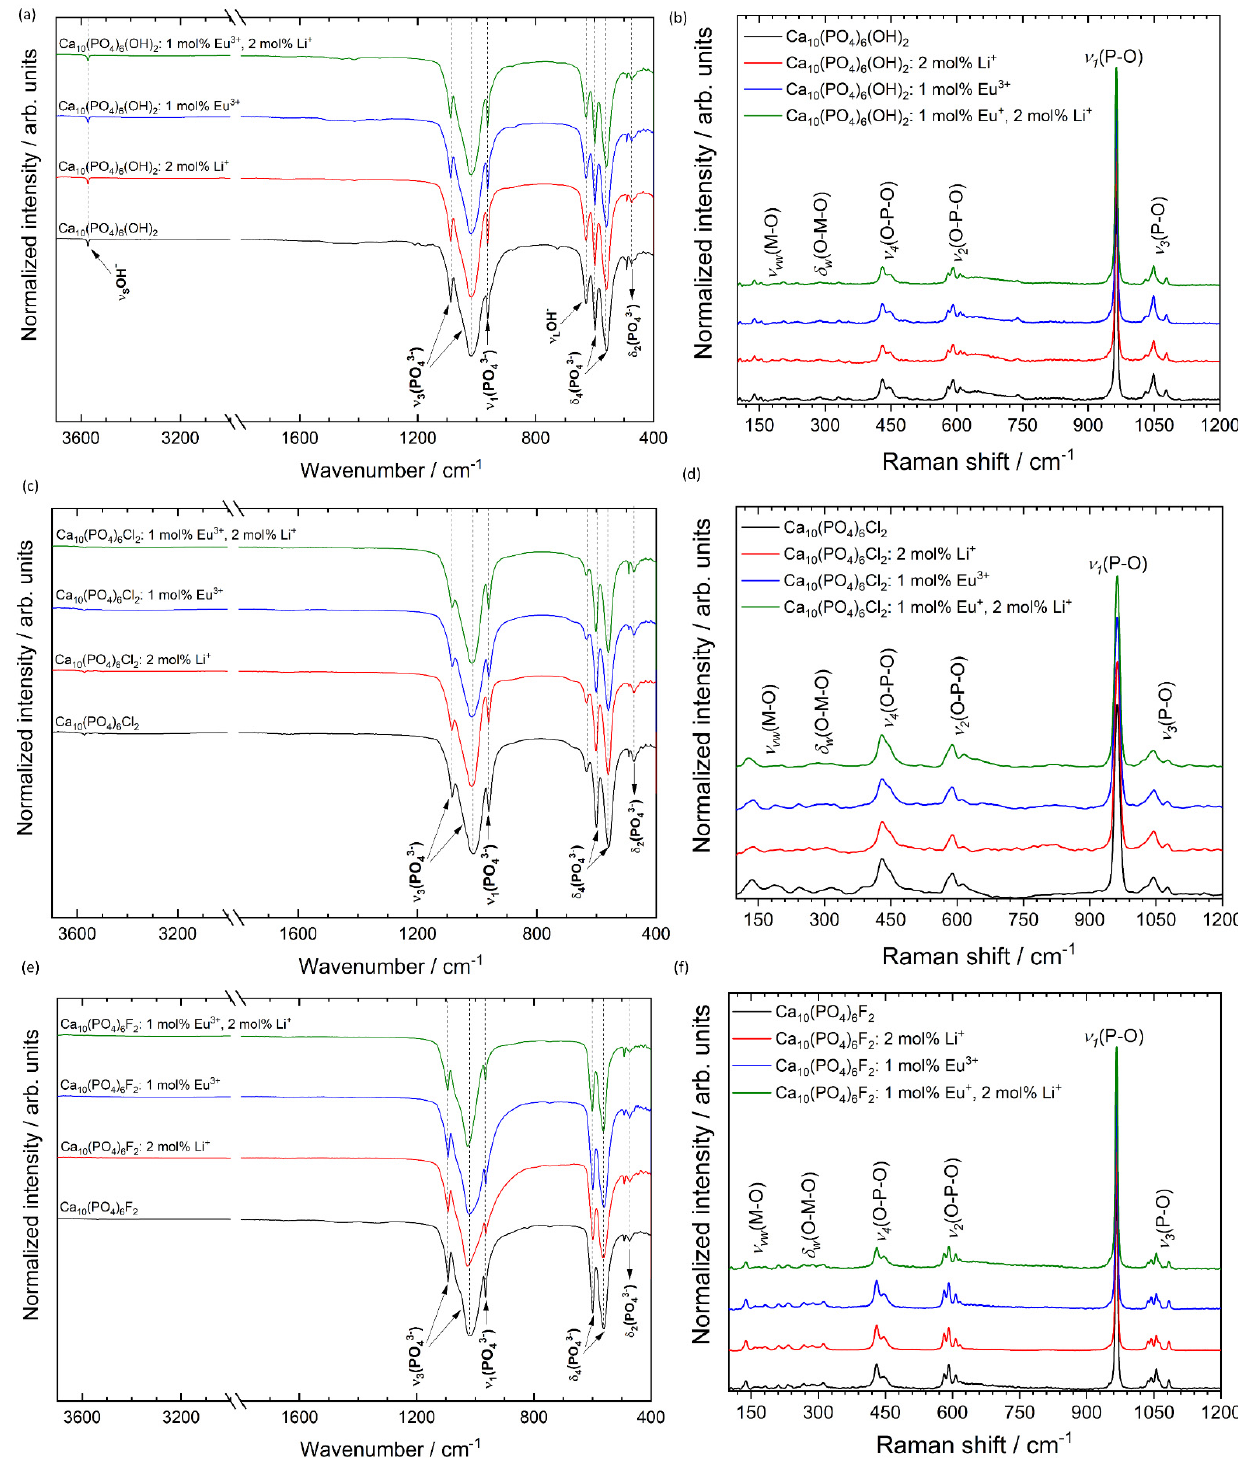
Figure 7. FT-IR ( left ) and micro-Raman ( right ) spectra of the Ca 10 (PO 4 ) 6 (OH) 2 ( a , b ), Ca 10 (PO 4 ) 6 Cl 2 ( c , d ), Ca 10 (PO 4 ) 6 F 2 ( e , f ) co-doped with 1 mol% Eu 3+ and 2 mol% Li + ions, prepared at 500 °C.